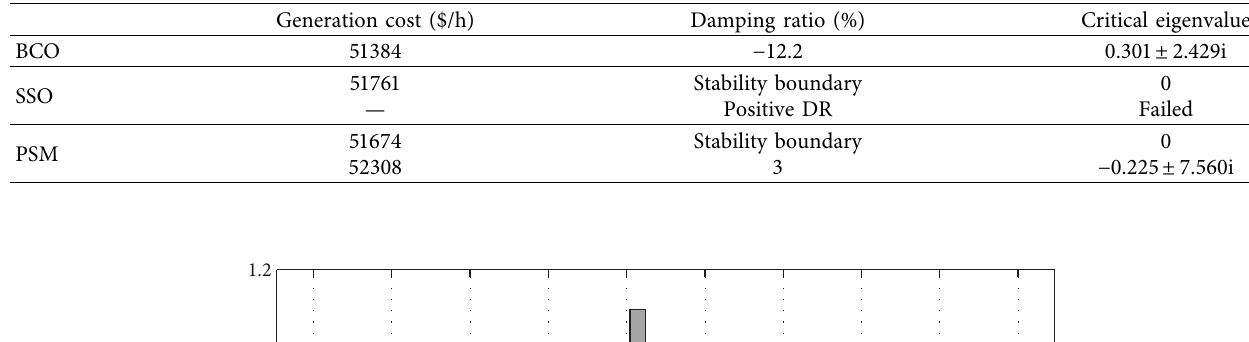
Table 3: Comparing performance of three methods in the IEEE 39-bus system.